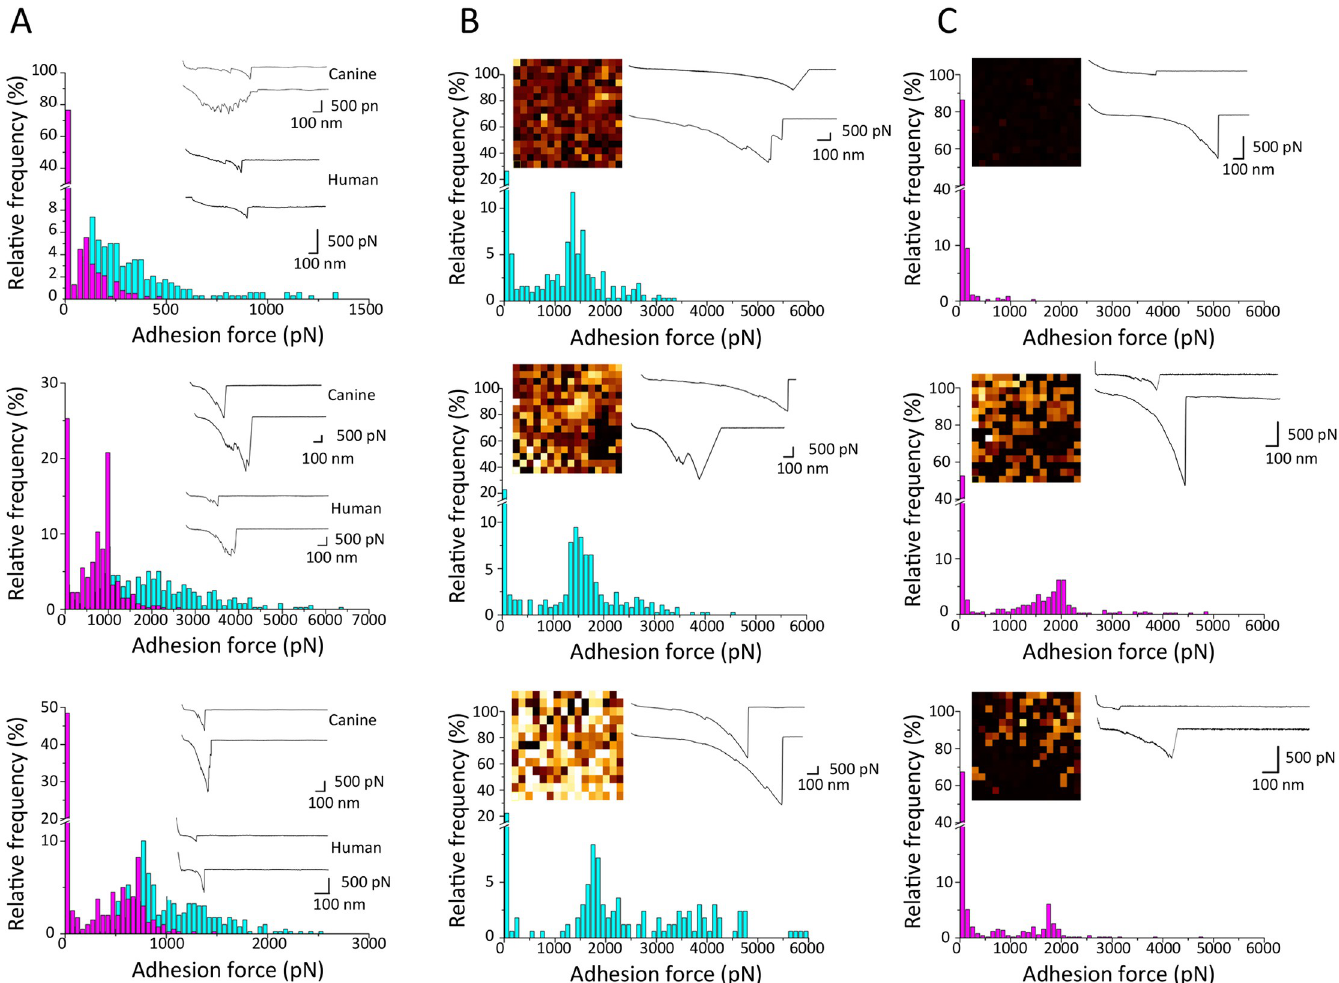
Fig 2. Atomic force microscopy analysis demonstrates increased binding strength of SpsL for canine fibrinogen. (A) Single-cell force spectroscopy (SCFS) measured the forces between single bacterial cells expressing SpsL A+SD and surfaces coated with either canine (blue) or human (purple) fibrinogen. Shown here are the adhesion force histograms with representative force curves obtained by recording force-distance curves in PBS for 3 different cells. All curves were obtained using a contact time of 100 ms, a maximum applied force of 250 pN, and approach and retraction speeds of 1,000 nm.s -1 . (B, C) Single-molecule force spectroscopy (SMFS) captured the localization and binding strength of single adhesins on living bacteria. Adhesion force histograms obtained by recording force curves in PBS across the surface of single bacteria with either canine (B) or human (C) fibrinogen tips. The insets show adhesion force maps (scale bars: 100 nm, color scales: 3,000 pN) and representative force curves. Each bright pixel represents the detection of single proteins, no binding is represented by a black pixel and strong binding is represented by a white pixel. All curves were obtained using a contact time of 100 ms, a maximum applied force of 250 pN, and approach and retraction speeds of 1,000 nm.s -1 .